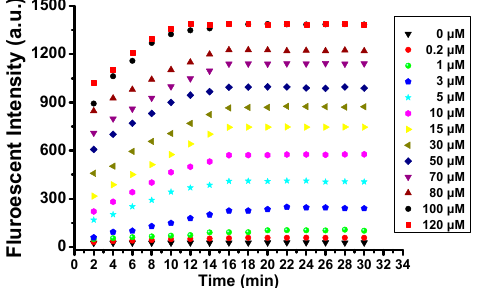
Figure 1. Time-dependent course of the interaction of PBD (10 µM) with GSH in EtOH-PBS buffer (Phosphate Buffered Saline) (10 mM, pH 7.4, 4:6, v / v ). Fluorescence intensity was recorded at 540 nm with λ ex = 405 nm.